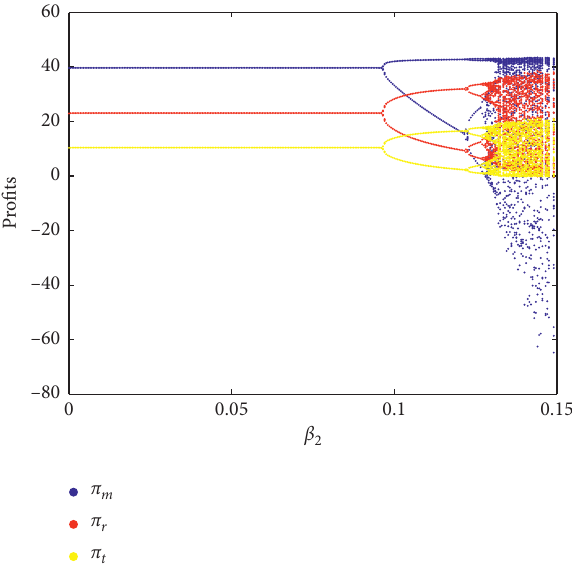
Figure 7: Bifurcation diagram of profits when β